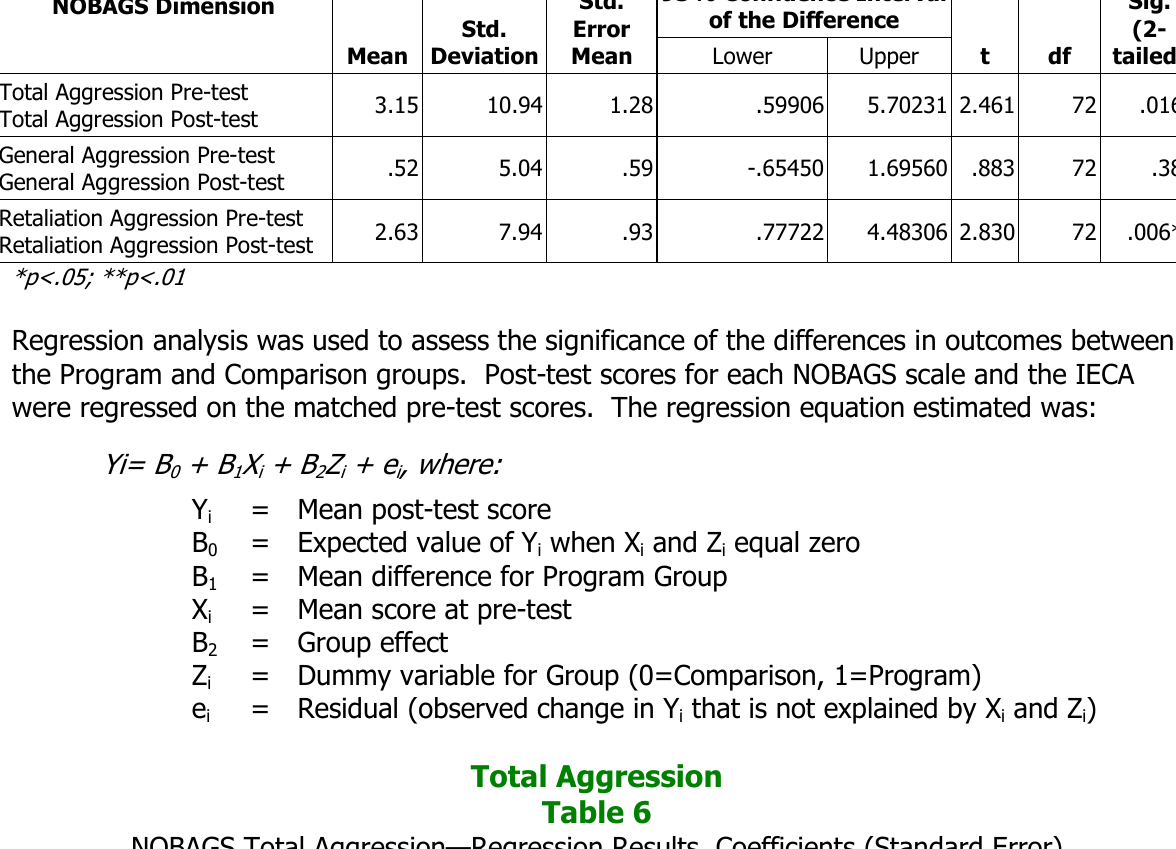
NOBAGS Total Aggression—Regression Results, Coefficients (Standard